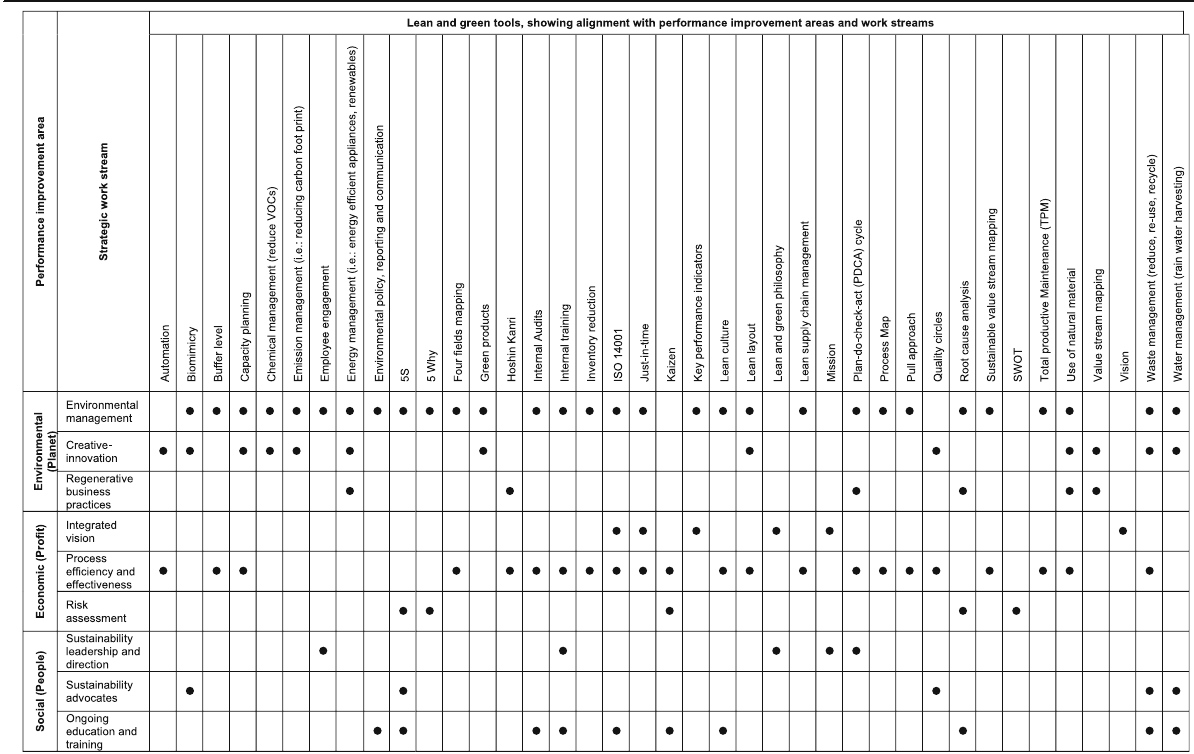
Caldera et al. Sustainable